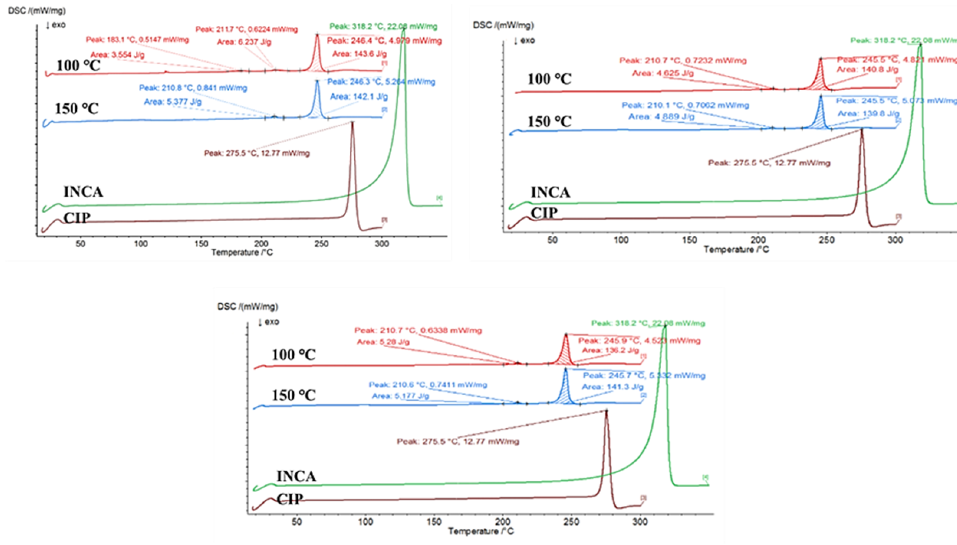
Figure A3. DSC thermograms of extrudates prepared at various temperature and screw speed using kneading screw configuration ( a ) 10 rpm, ( b ) 55 rpm, and ( c ) 100 rpm.